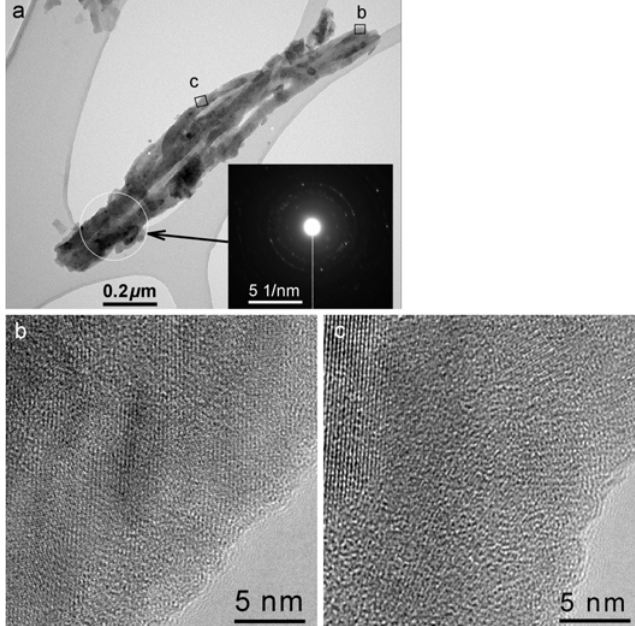
Figure 1. TEM observation of heat-treated clay powder: (a) Overview and electron diffraction pattern, (b) and (c) HR-TEM micrographs taken at the indicated position of a clay